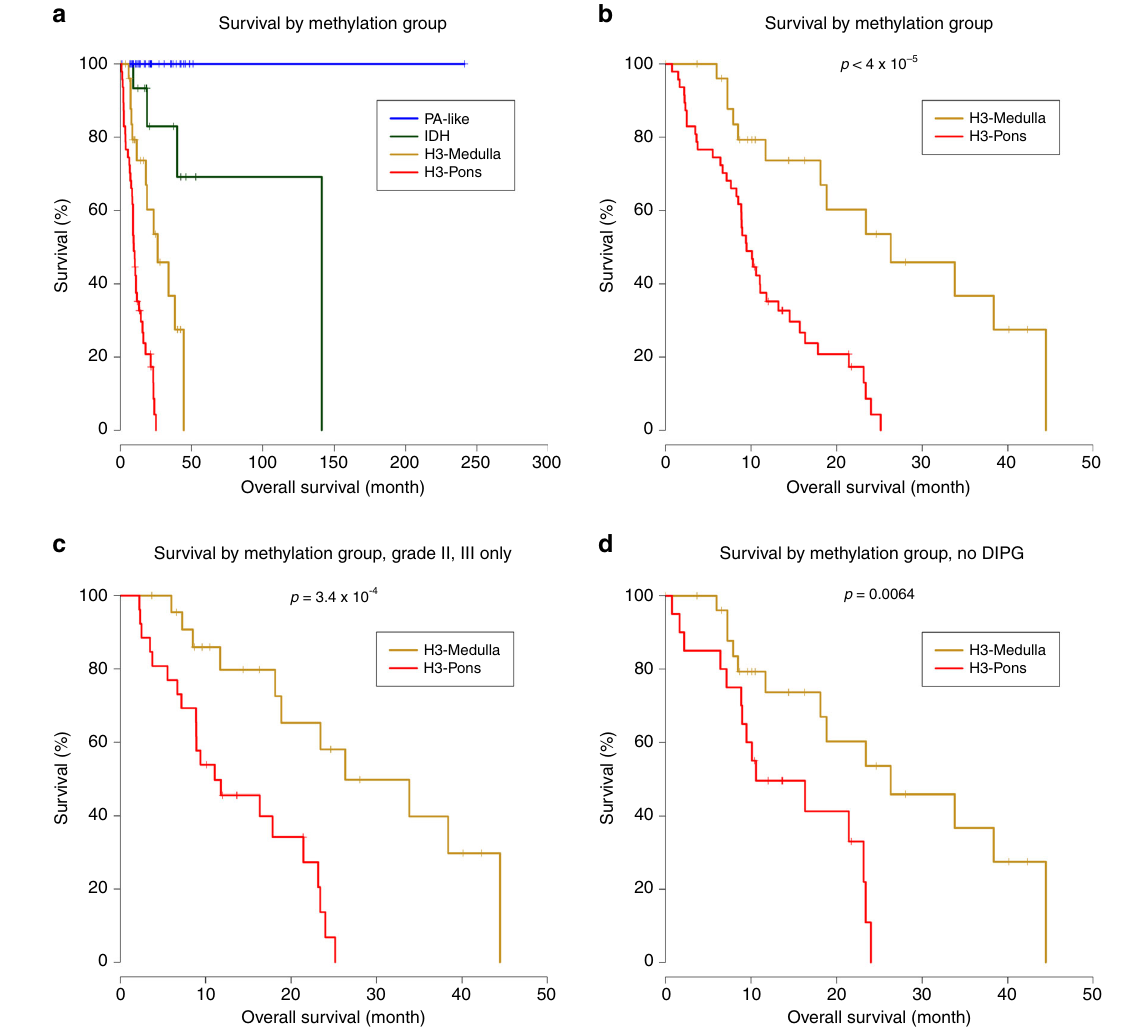
Fig. 6 Methylation clusters correlate with distinct survival prognosis (Kaplan – Meier curves and log-rank test). a Survival analysis of brainstem glioma patients for four clusters. b Survival analysis of H3-Medulla and H3-Pons only. Log-rank test p < 4 × 10 − 5 ( c ) Survival analysis of H3-Medulla and H3-Pons, selected samples from tumor of grade II and grade III only. d Survival analysis of H3-Medulla and H3-Pons, selected samples from tumors of non- DIPG